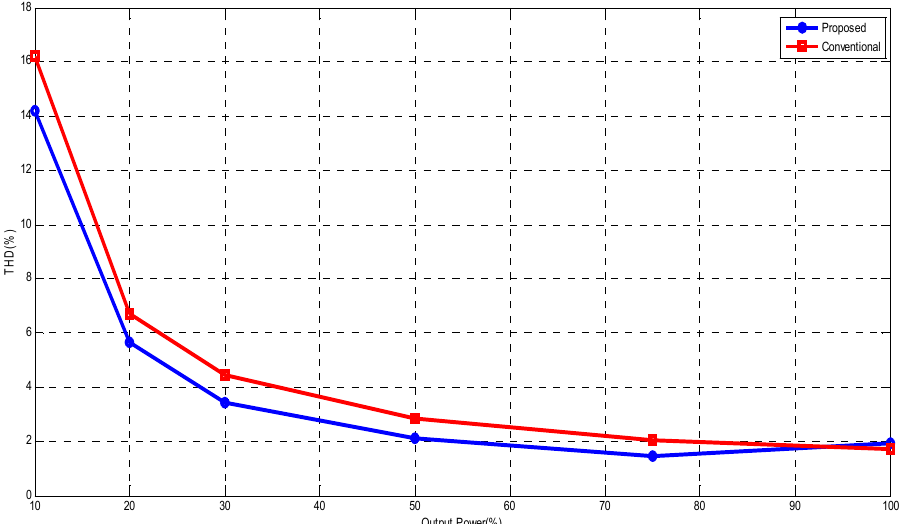
Figure 9. The variation of system efficiency with output power of both conventional and proposed systems.